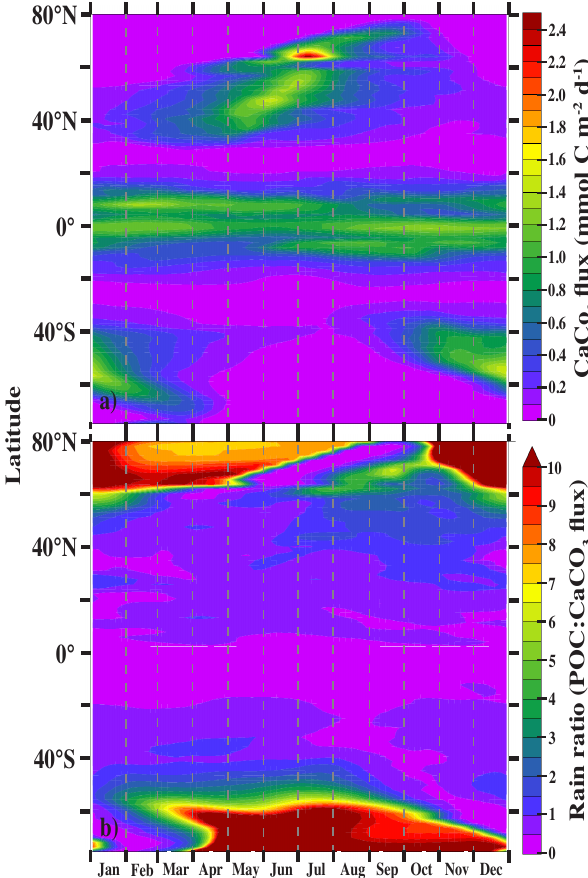
Fig. 23. Hovm¨oller diagrams of the zonally averaged simulated sea- sonal fluxes of (a) PIC and the (b) rain ratios at